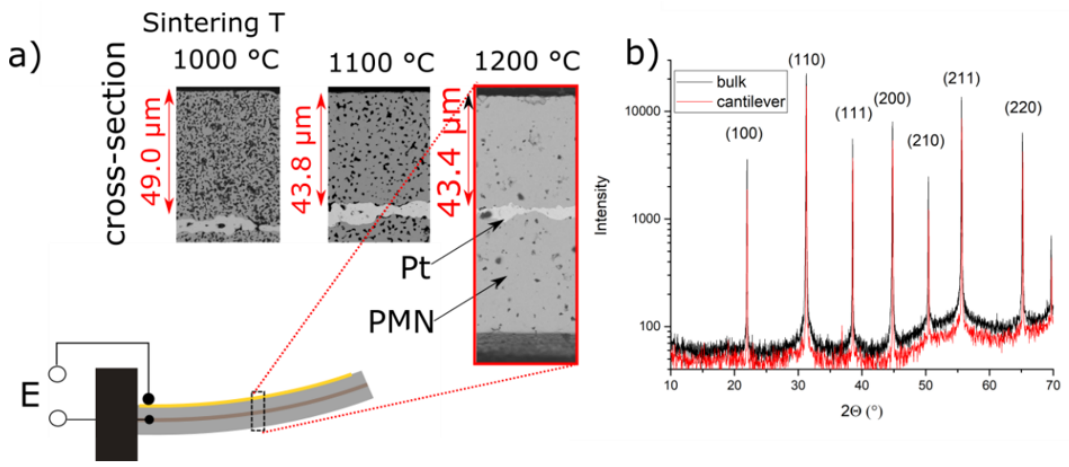
Figure 2. (Micro)structure of the cantilever sample used in the study. ( a ) SEM micrographs showing the microstructures of the three cantilevers sintered at three different temperatures. As shown in the bottom-most inset, the cantilever consisted of three layers, i.e., PMN, Platinum (Pt) and another PMN layer. When an electric field ( E ) is applied to the upper PMN layer, the cantilever bends, as shown schematically in the bottom inset). ( b ) XRD patterns of PMN in the bulk ceramic and cantilever form. Both show a pseudo-cubic perovskite structure with no secondary pyrochlore phases.